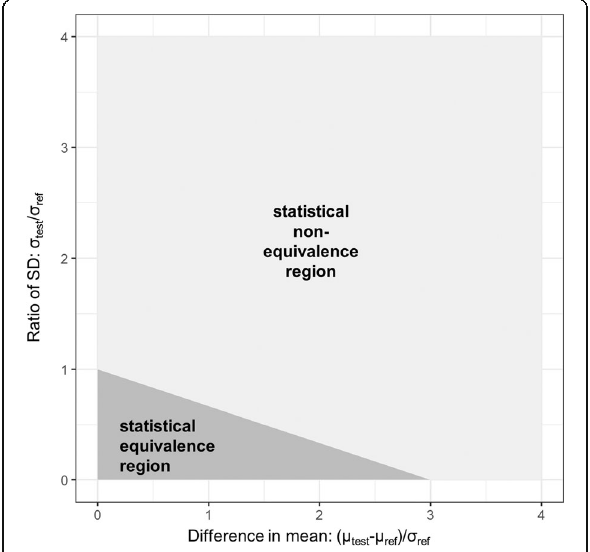
Fig. 1 Definition of the statistical equivalence region: The dark grey region is the defined true similarity region and indicates those combinations of SD ratio and difference in mean where the test population is within the reference population. The population width is described by μ ± 3 σ , which translates into a triangle with the corners of SD ratio and difference in means of (0/0, 1/0, 0/3). The light grey region is the statistical non-equivalence (false similarity) region indicating where the test population is not considered to be within the reference